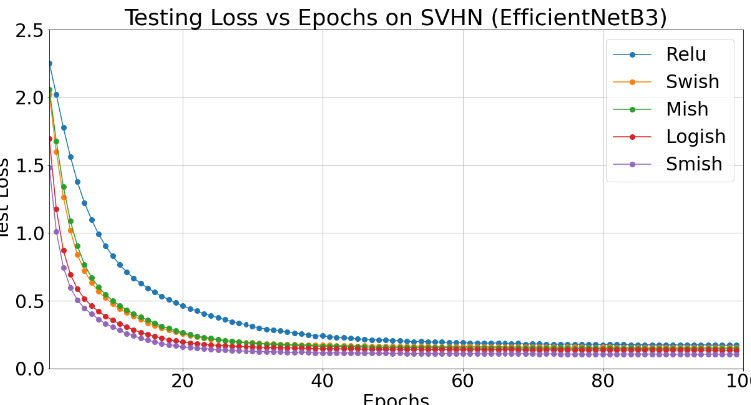
Figure 14. Loss vs. epochs in EfficientNetB3 achieved via the five activation functions on SVHN.